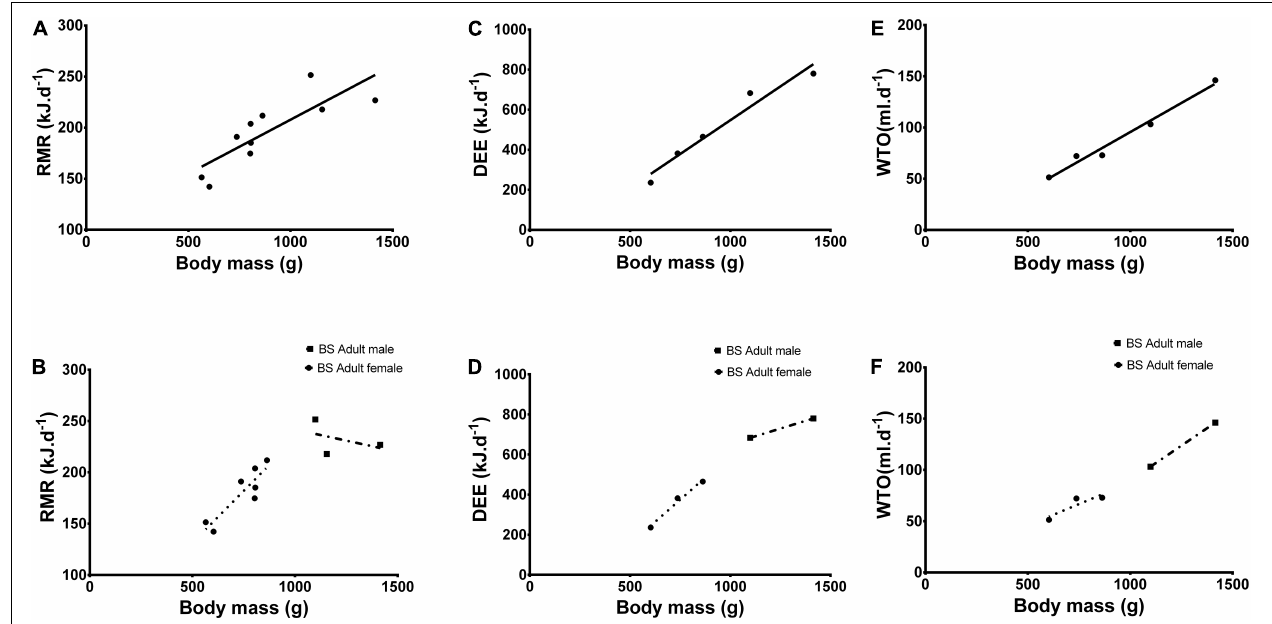
FIGURE 2 | (A) Resting metabolic rate (RMR- kJ.d – 1 ), (C) daily energy expenditure (DEE- kJ.d – 1 ) and (E) water turn over (WTO- ml.d – 1 ) against body mass (g) of adult Bathyergus suillus (BS). (B) RMR, (D) DEE and (F) against male and female adult Bathyergus suillus (BS) body mass. Solid circles ( • ) and solid squares ( (cid:4) ) represent female and male adult Bathyergus suillus (BS),